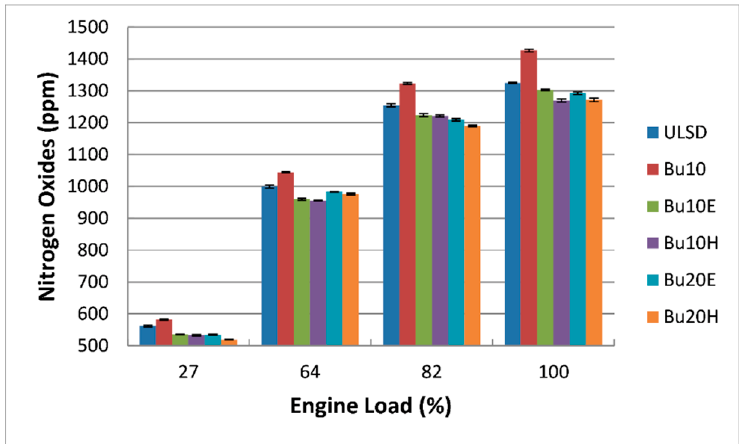
Figure 11. Nitrogen oxide emissions of the six fuels with the same DCN.